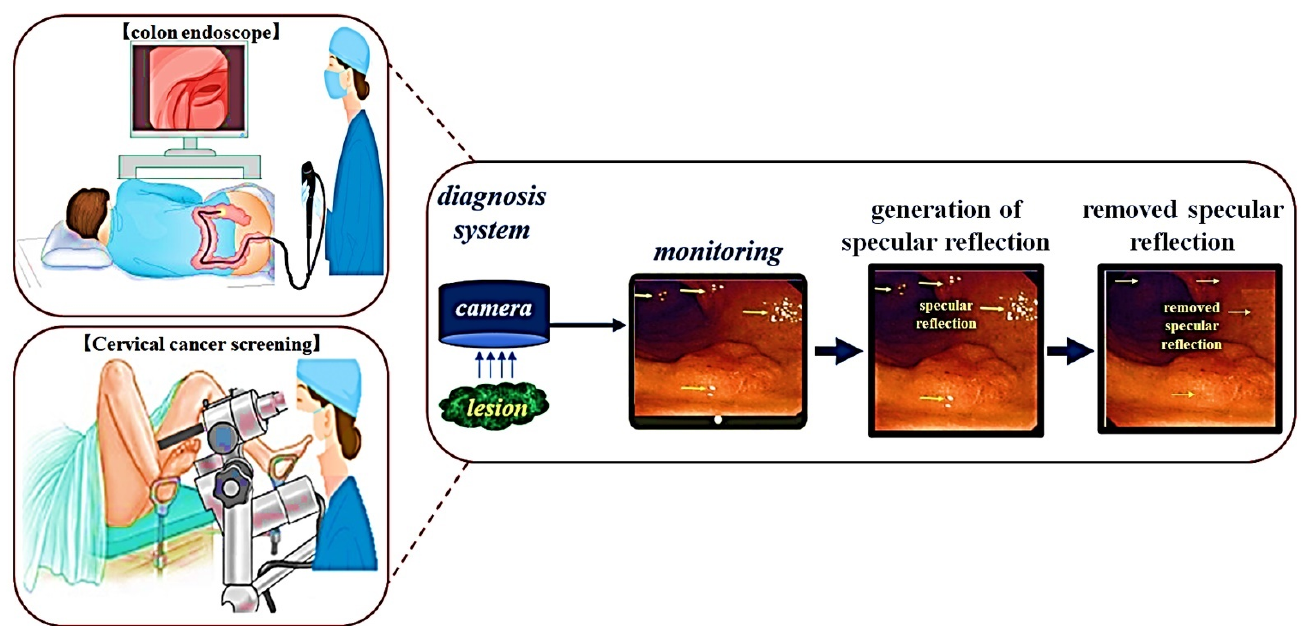
Figure 1. Generation of specular reflection in the diagnosis progress (The occurrence of light reflections from colonoscopy diagnosis and cervical endoscopy. In addition, the phenomenon of obstructing the observation of the lesion due to the occurrence of light reflection).